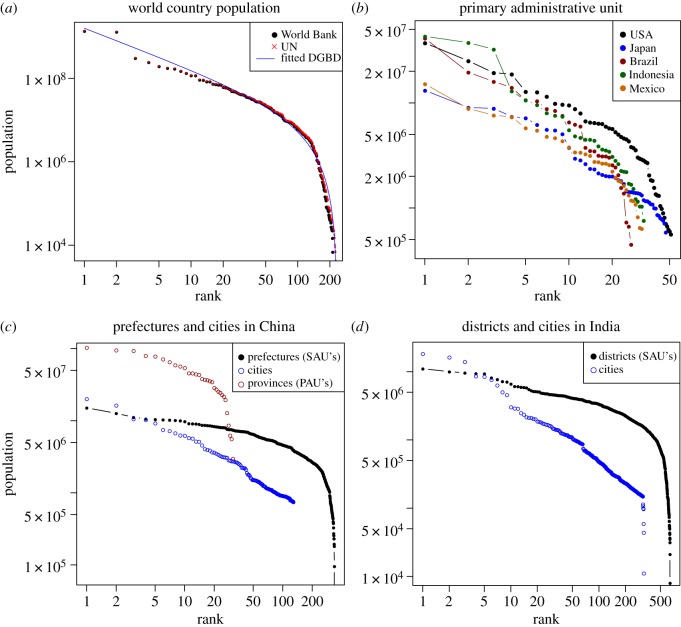
Examples of deviations from power laws. (a) Ranked population of countries and territories of the world according to data of the World Bank and the UN; the red line is the DGBD fit to the UN data. (b) Ranked population of primary administrative units in five different countries (states in the USA, Brazil and Mexico; prefectures in Japan; and provinces in Indonesia). (c) Ranked population of prefectures, cities and provinces in China. (d) Ranked population of districts and cities in India. All plots are on log–log scales.